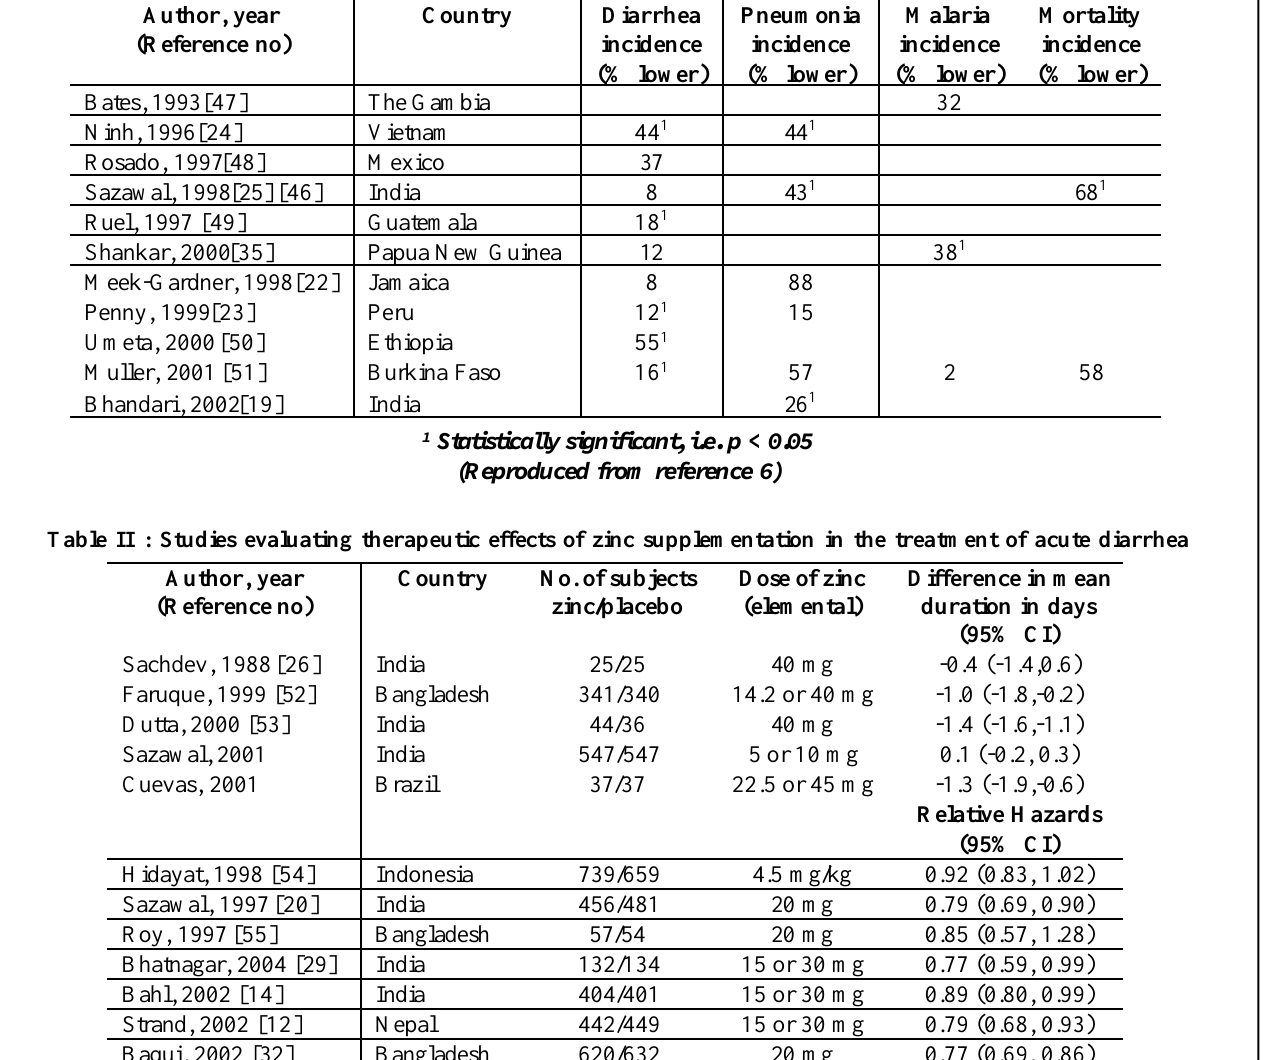
Table I : Effects of zinc in prevention of diarrhea, pneumonia, malaria and mortality in children